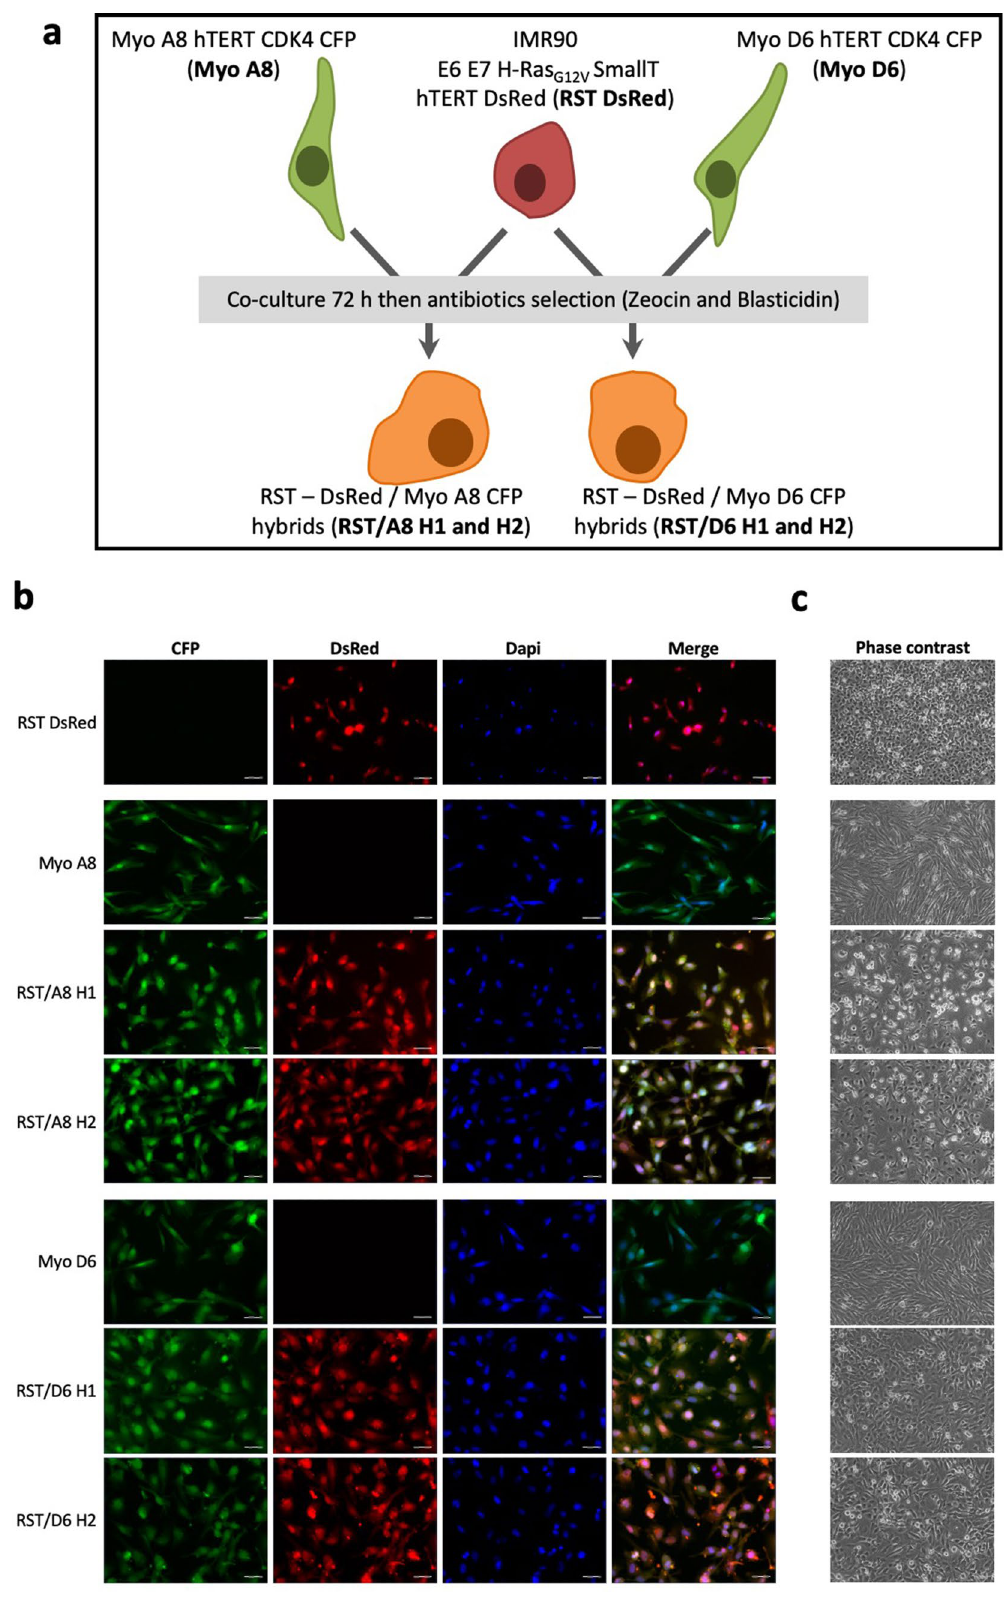
Figure 1. Hybrid selection and identification. ( a ) Schema of hybrid generation. RST-DsRed + is co-cultured with Myo A8 CFP + or Myo D6-CFP + cell lines and spontaneous fusion DsRed+–CFP+ cells are isolated. Hybrid cells are selected following antibiotics treatment (Zeocin and Blasticidin). ( b ) Fluorescence panels of parental RST DsRed, Myo A8 CFP and Myo D6 CFP and all hybrids cells. Scale bar = 50 μm. ( c ) Phase contrast panel of parental RST DsRed, Myo A8 CFP and Myo D6 CFP and all hybrids cells. (Objective =